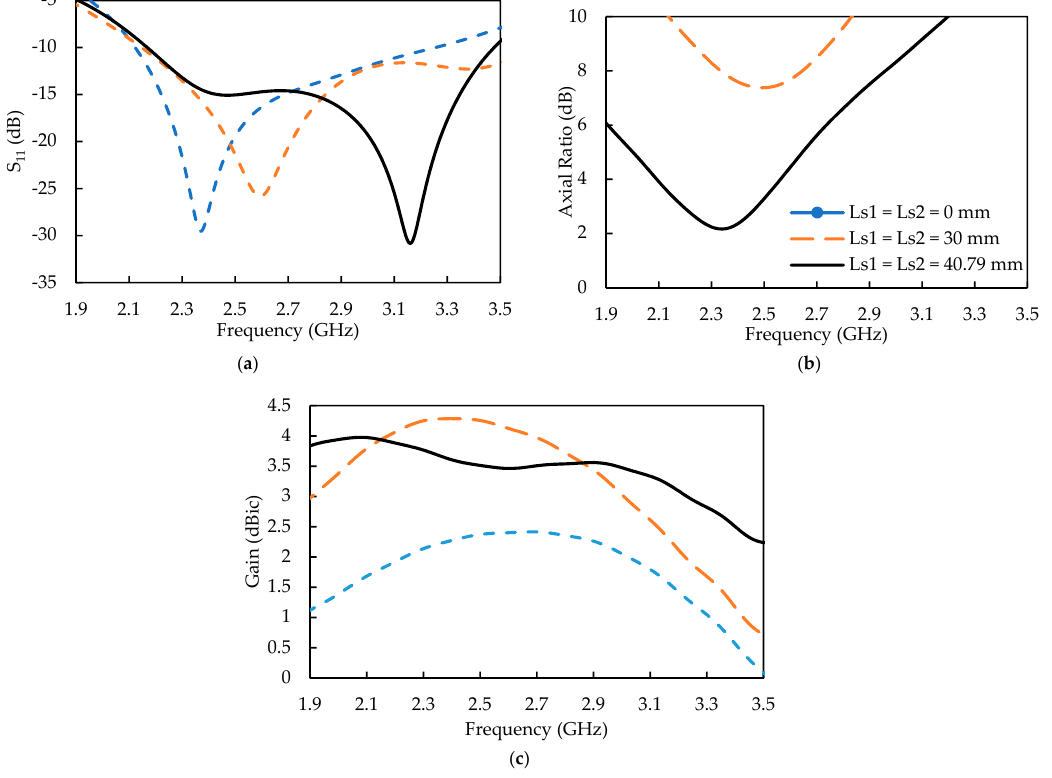
Figure 3. Effect of the symmetrical slot length of 0, 30, and 40.79 mm on ( a ) S 11 , ( b ) axial ratio, and ( c ) gain.